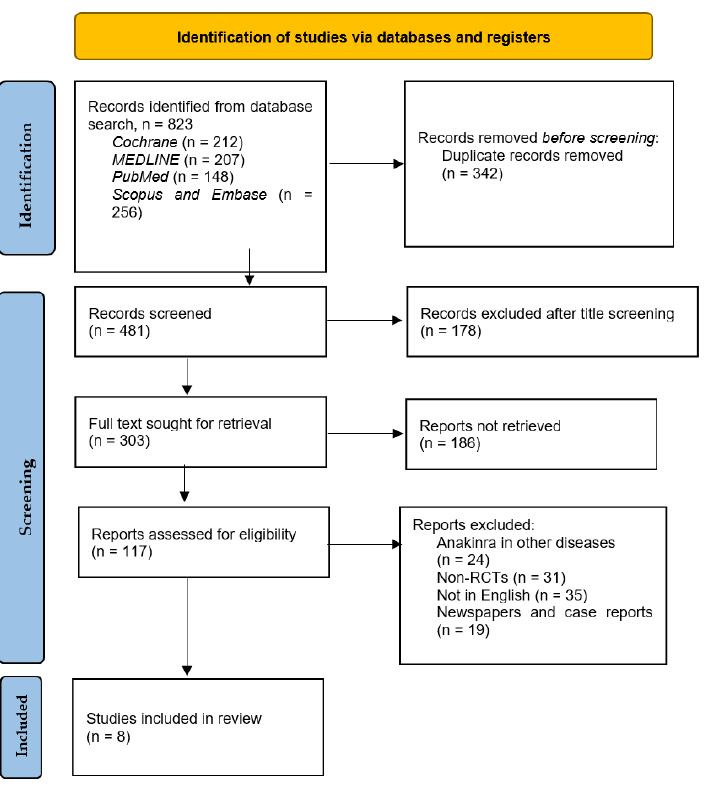
Figure 2. PRISMA flowchart depicting the search process utilized to arrive at the eight RCTs. Table 1. Outcomes studied in the trials of use of anakinra in heart failure.